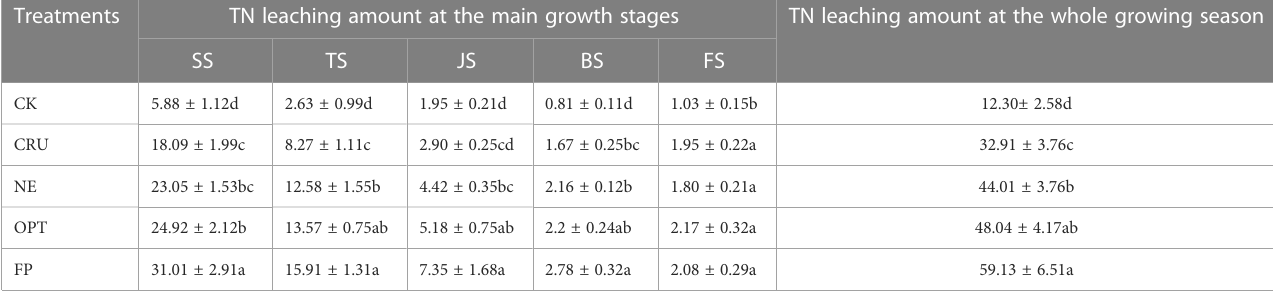
TABLE 2 Total nitrogen (TN) leaching amount at 100 cm soil depth in paddy fi elds under different treatments during different growth stages (unit: kg hm -2 ).